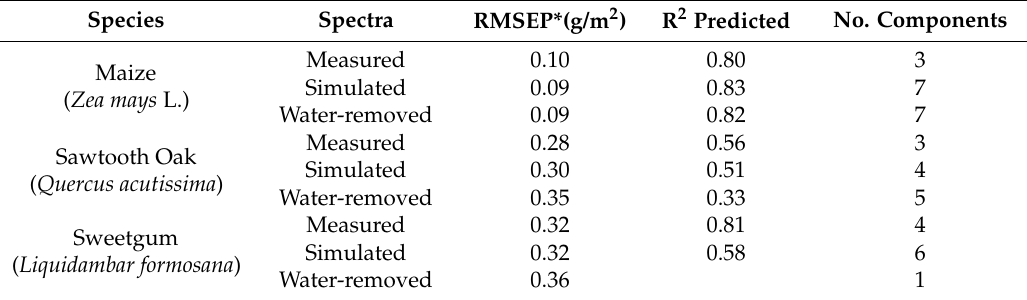
Table 4. Statistics of the partial least square regression (PLSR)